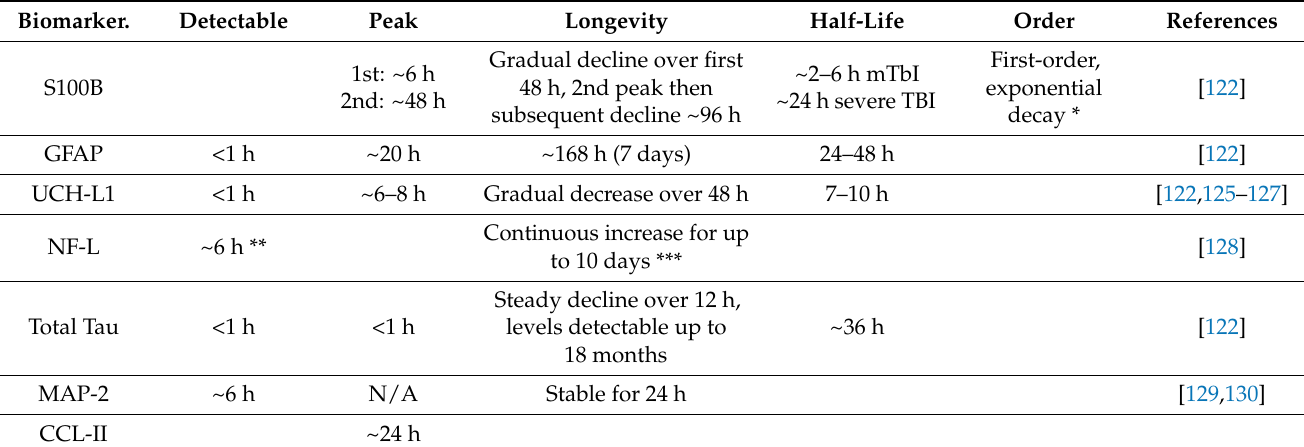
Table 5. Kinetic parameters of select blood/serum/plasma-based biomarkers.